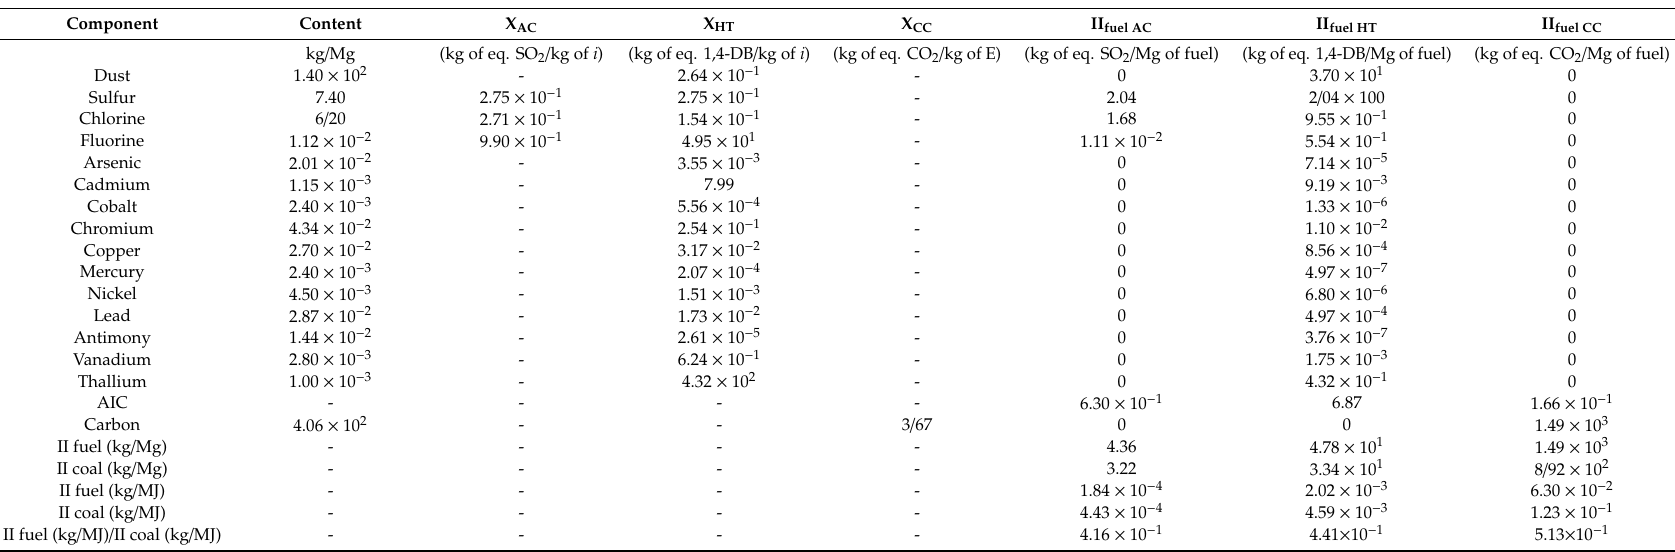
Table 3. Environmental harmful e ff ects of the waste mixture obtained during the first measurement